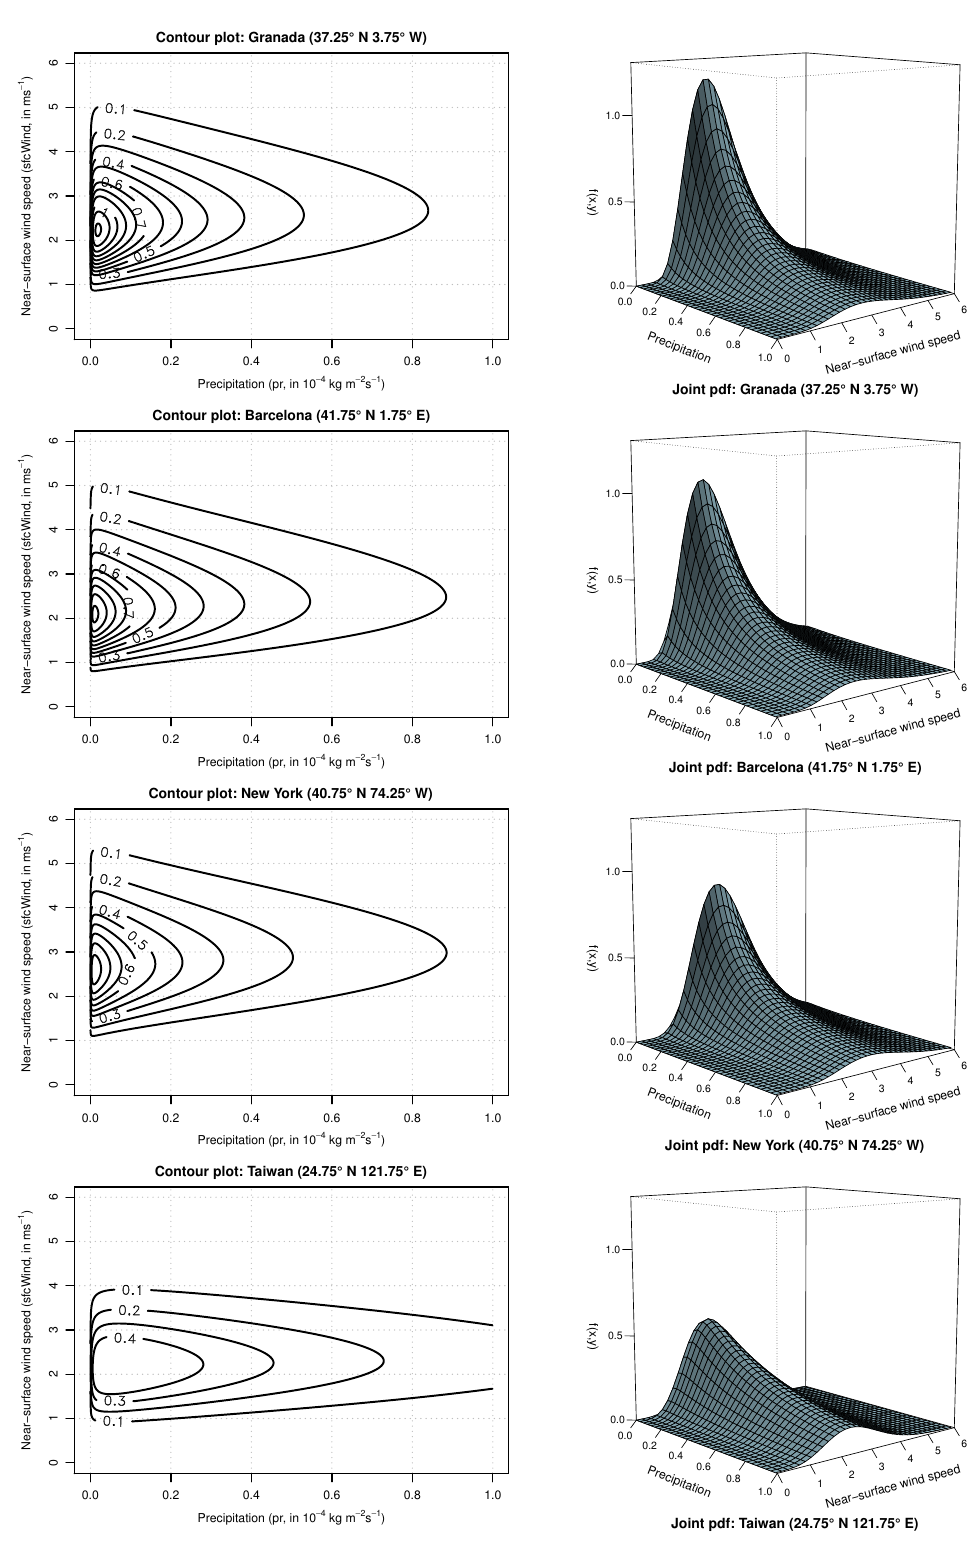
Figure 4. Contour plots and joint pdf of the bivariate GB2 distribution with q fixed, corresponding to the four grid points indicated in Table